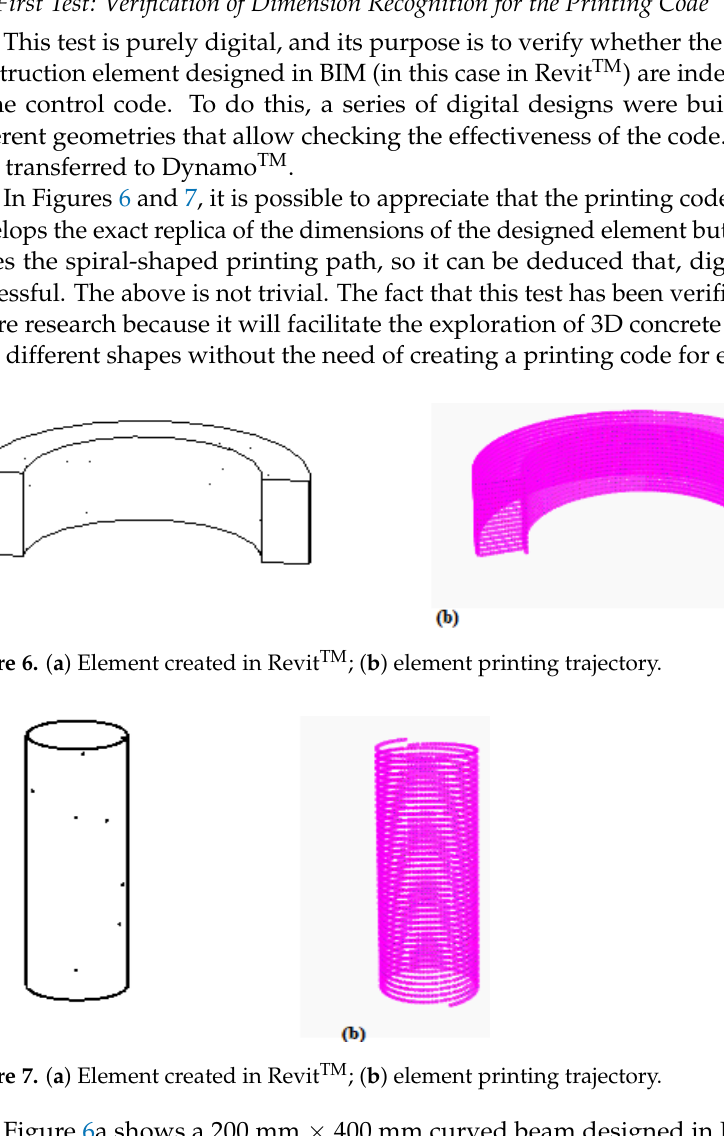
Figure 8. ( a ) Start of the printed sample, ( b ) succession of layers of the printed sample, and ( c ) other 3D concrete printed elements that were tested.